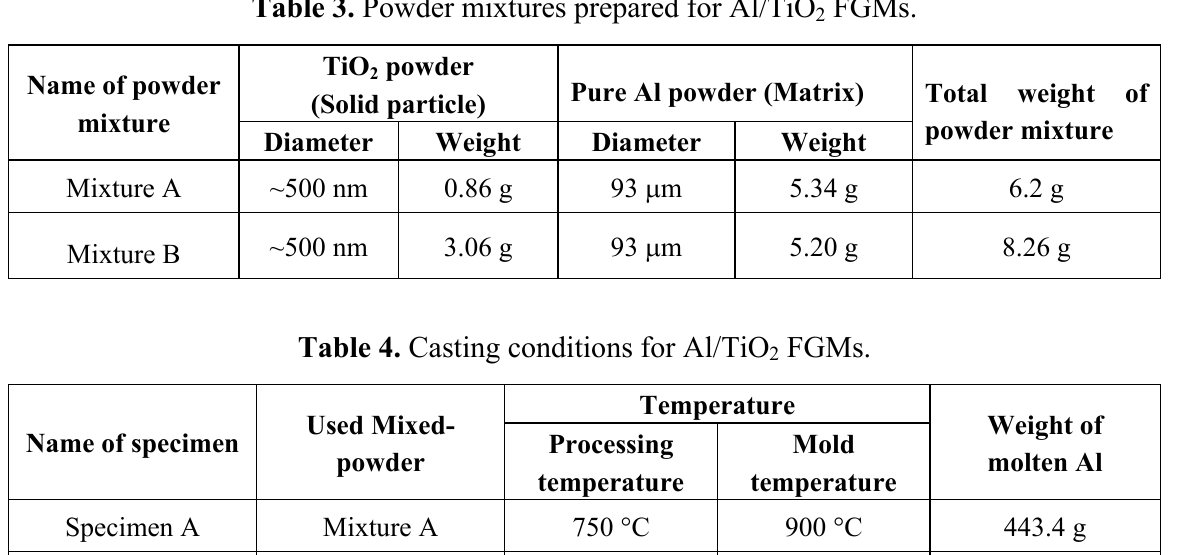
Table 3. Powder mixtures prepared for Al/TiO